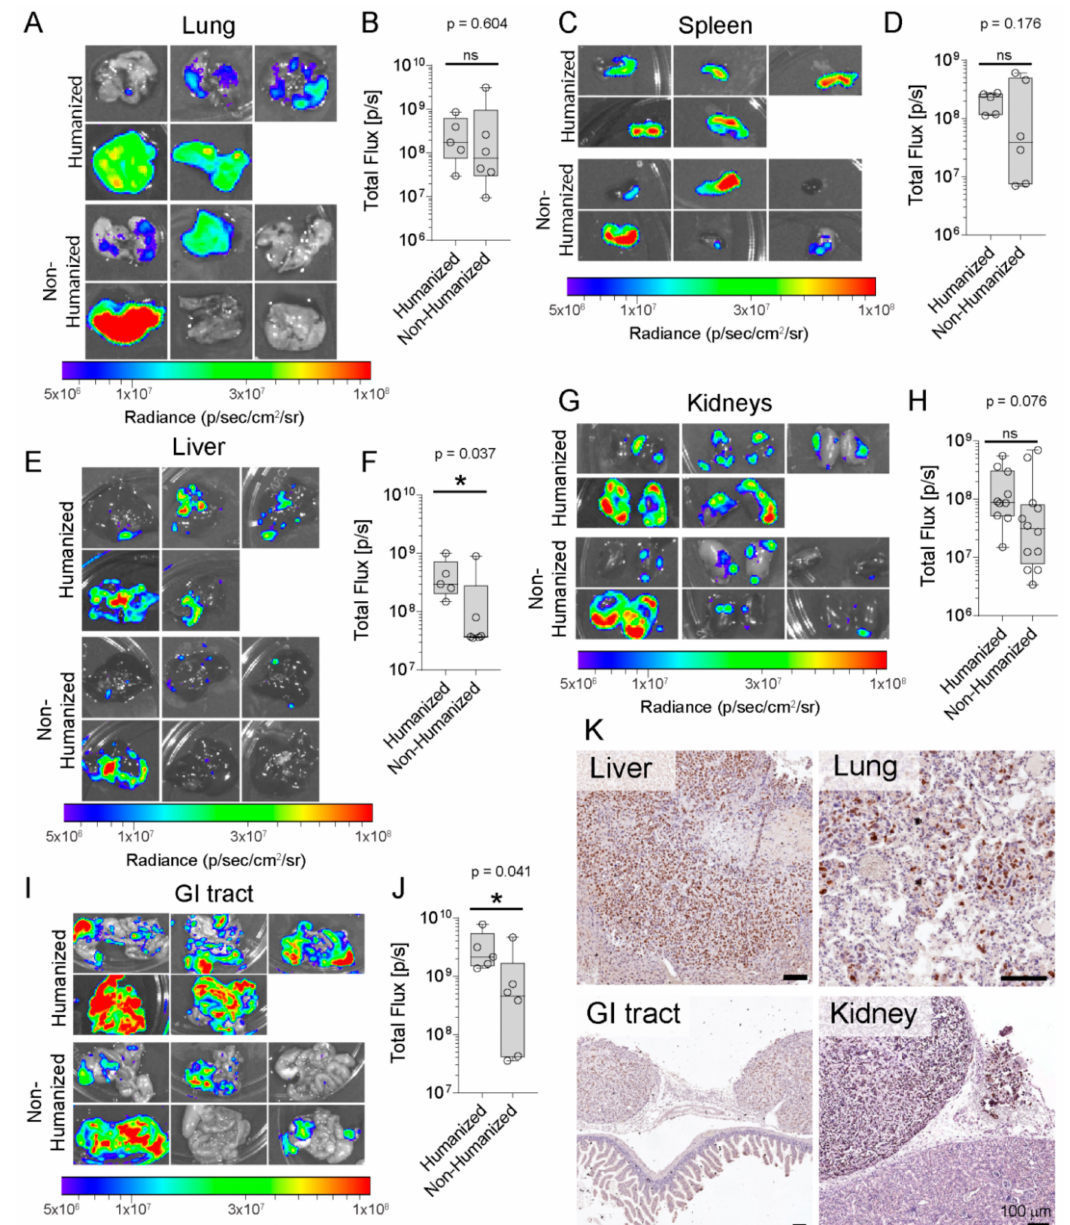
Figure 4. PC3-luc cells metastasized from an orthotopic tumor to the murine organs. ( A ) Ex vivo BLI of metastases to the murine lung ( B ) and IVIS quantification (n = 5–6 lungs per group). The presence of PC3-luc metastases in the murine spleen was detected with ex vivo BLI, ( C ) images of murine spleen and ( D ) corresponding total flux demonstrated no significant differences between both groups (n = 5–6 spleens per group). ( E ) Surface colonization of PC3-luc cells on the murine kidneys and ( F ) quantitative analysis showed no significant differences between groups (n = 10–12 kidneys per group). ( G ) Ex vivo BLI of metastases to the murine liver ( H ) and BLI signal quantification (n = 5–6 livers per group) demonstrate a statistically significant difference in tumor burden between both groups ( p = 0.037). ( I ) Surface colonization of PC3-luc cells on the murine GI tract and ( J ) quantitative analysis shows significant differences between groups (n = 5–6 GI tracts per group; p = 0.041). ( K ) IHC detection of hsNuMA in the murine lung, kidney, liver and GI tract tissue sections. Data are represented as individual values within box plots. Statistical analysis was performed using an independent t -test for parametric data, or a Mann-Whitney U test for non-parametric data. Scale bars represent 100 µ m. The asterisk (*) represents statistically significant differences between groups ( p < 0.05) and ns: not